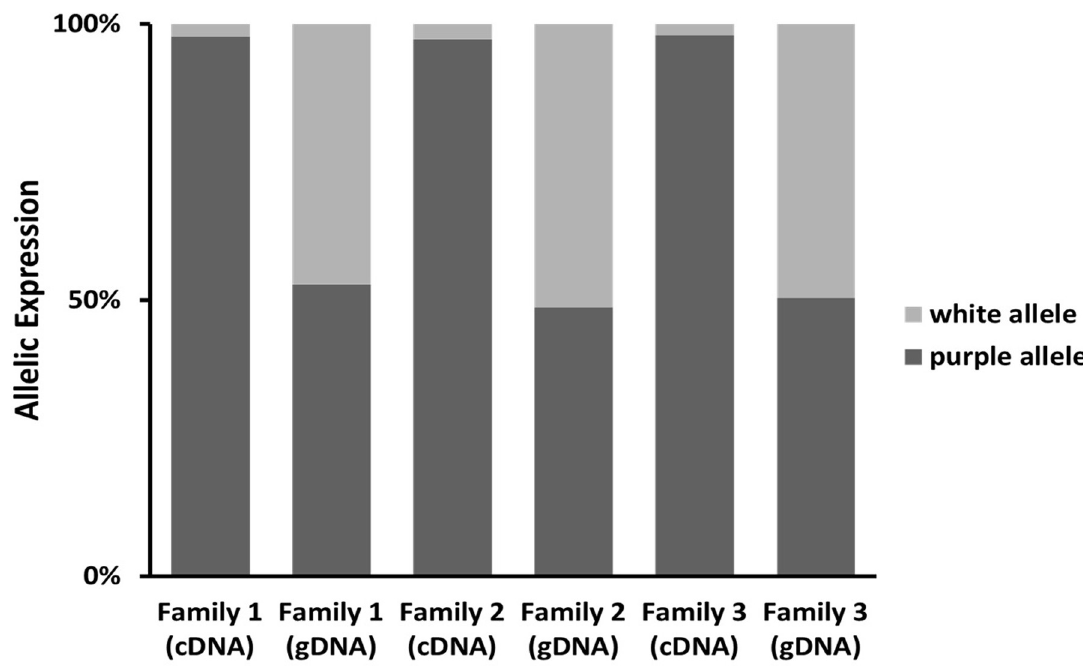
Fig 3. Allele-specific expression of R2R3-Myb in heterozygotes. Proportions of alleles sequenced using cDNA and gDNA as template for heterozygotes derived from three families.